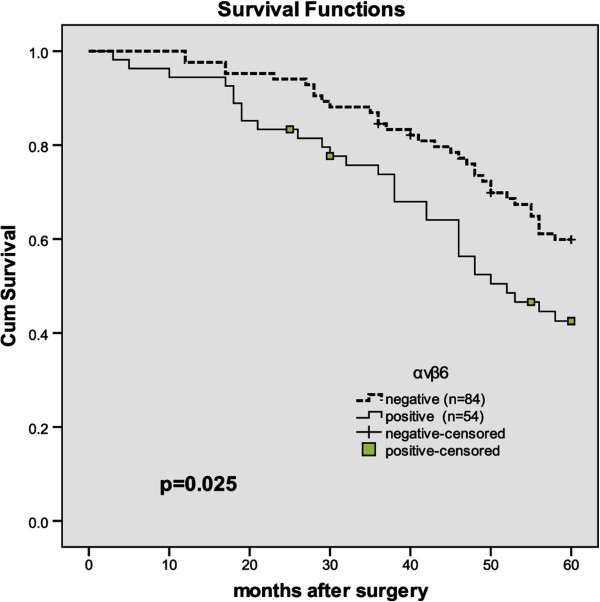
Overall survival according to αvβ6 expression (P = 0.025, The log-rank test).